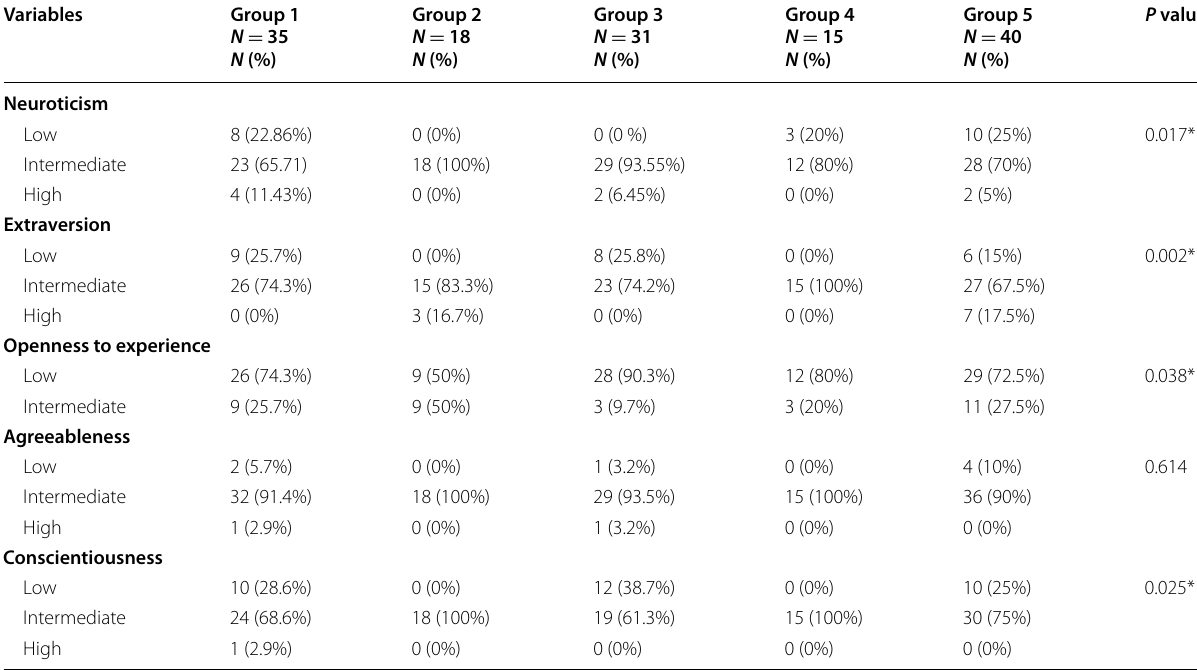
Group 1: carbamazepine, group 2: valproate, group 3: carbamazepine and clonazepam, group 4: valproate and clonazepam, group 5: epileptic patients without antiepileptic drugs (AEDs), *significant P value